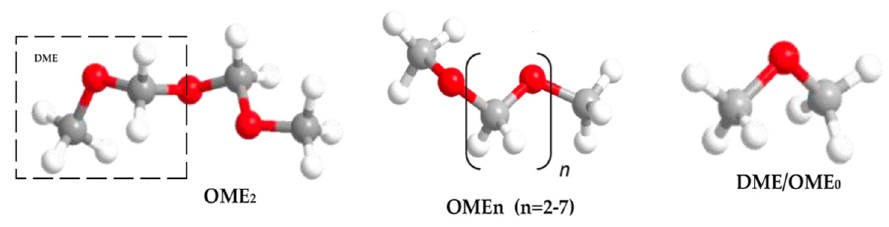
Figure 12. Nomenclature of OMEx.